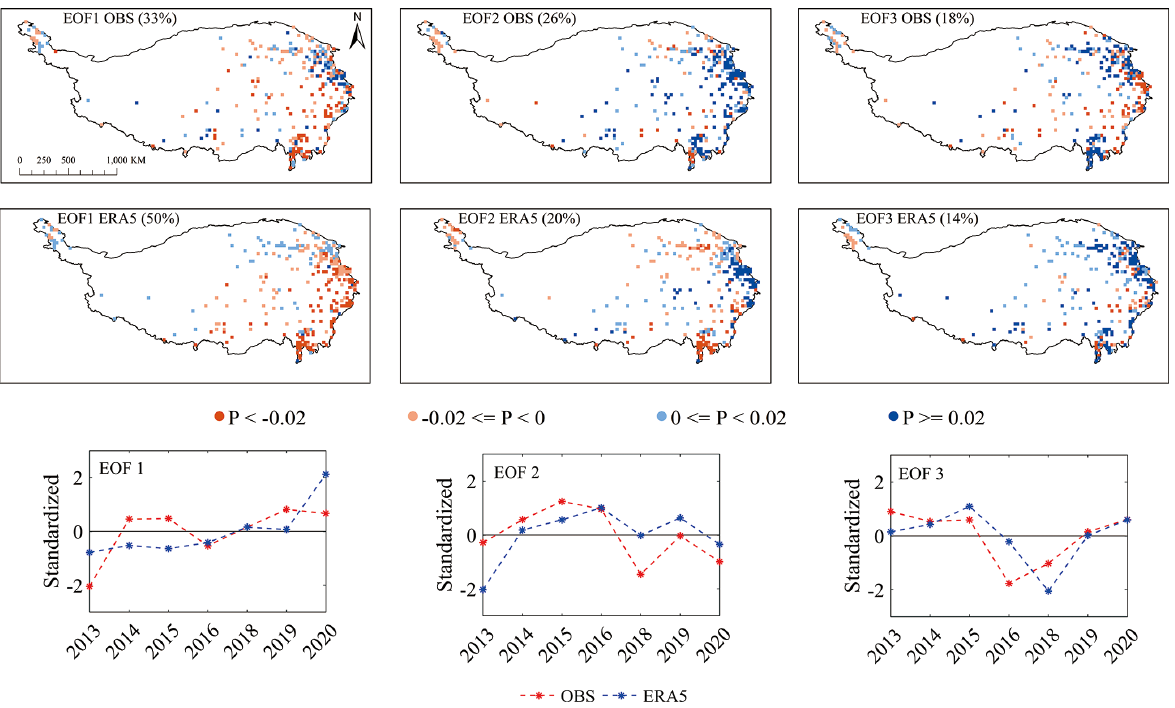
Figure 7. First three empirical orthogonal function (EOF) modes of observed and ERA5-based mean annual rainfall erosivity on the TP in 2013–2020 (excluding 2017).